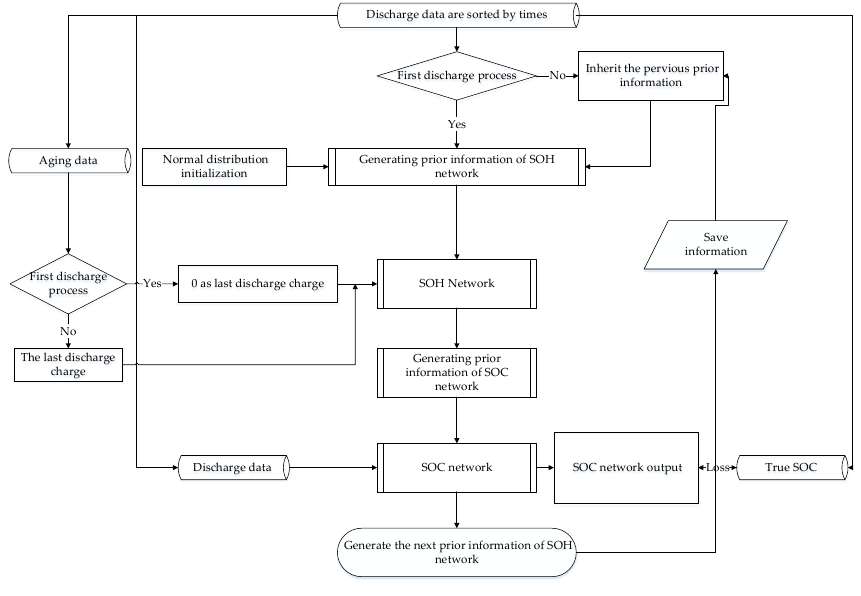
Figure 6. Network training